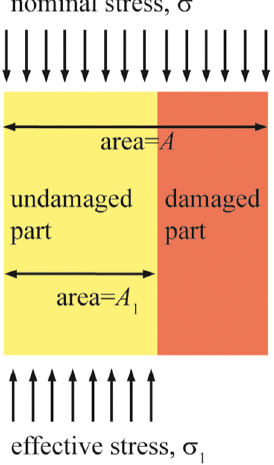
Figure 6: The schematic diagram of the axial stress of TFPU grouting material under